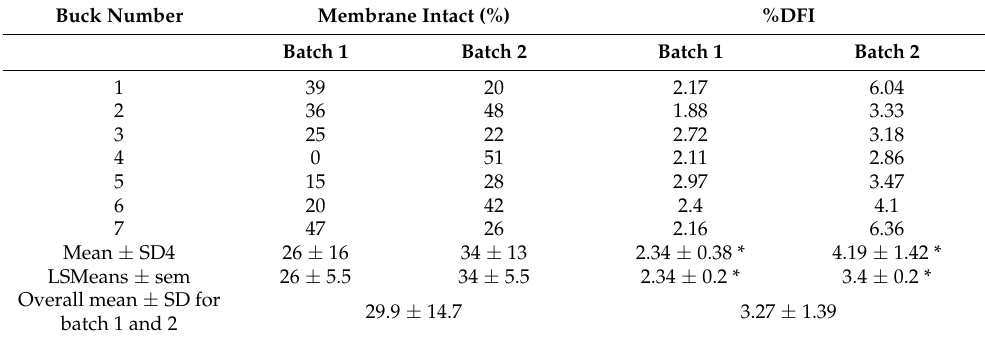
Table 4. Membrane integrity and DNA fragmentation (LSMeans ± sem) in frozen buck spermatozoa.